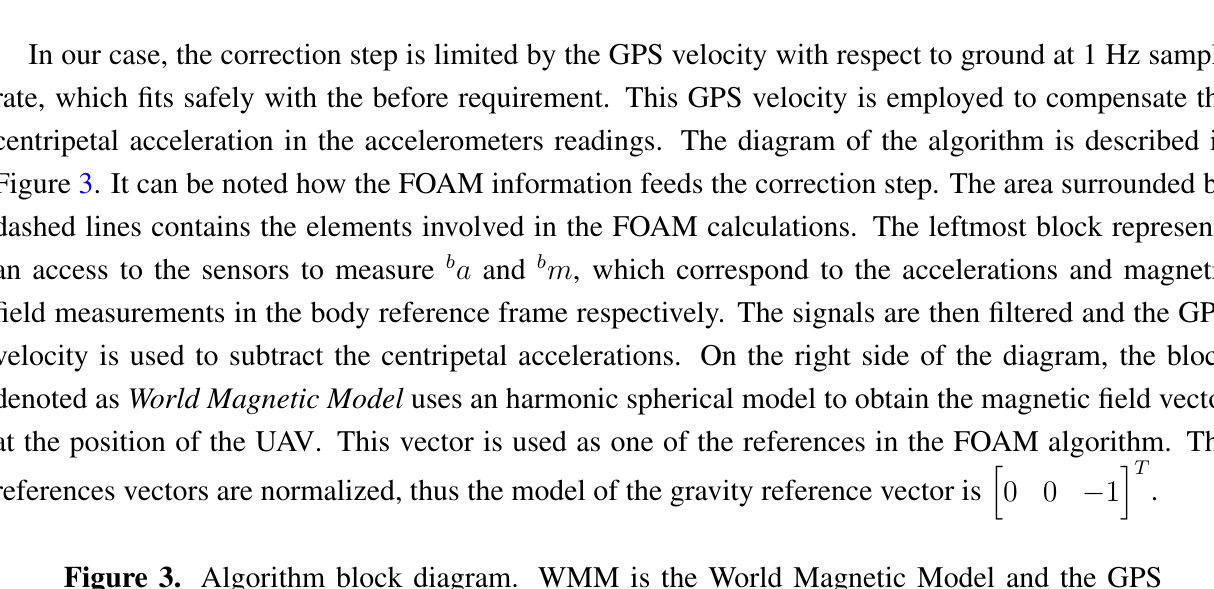
Figure 3. Algorithm block diagram. WMM is the World Magnetic Model and the GPS velocity is employed for subtract the centripetal